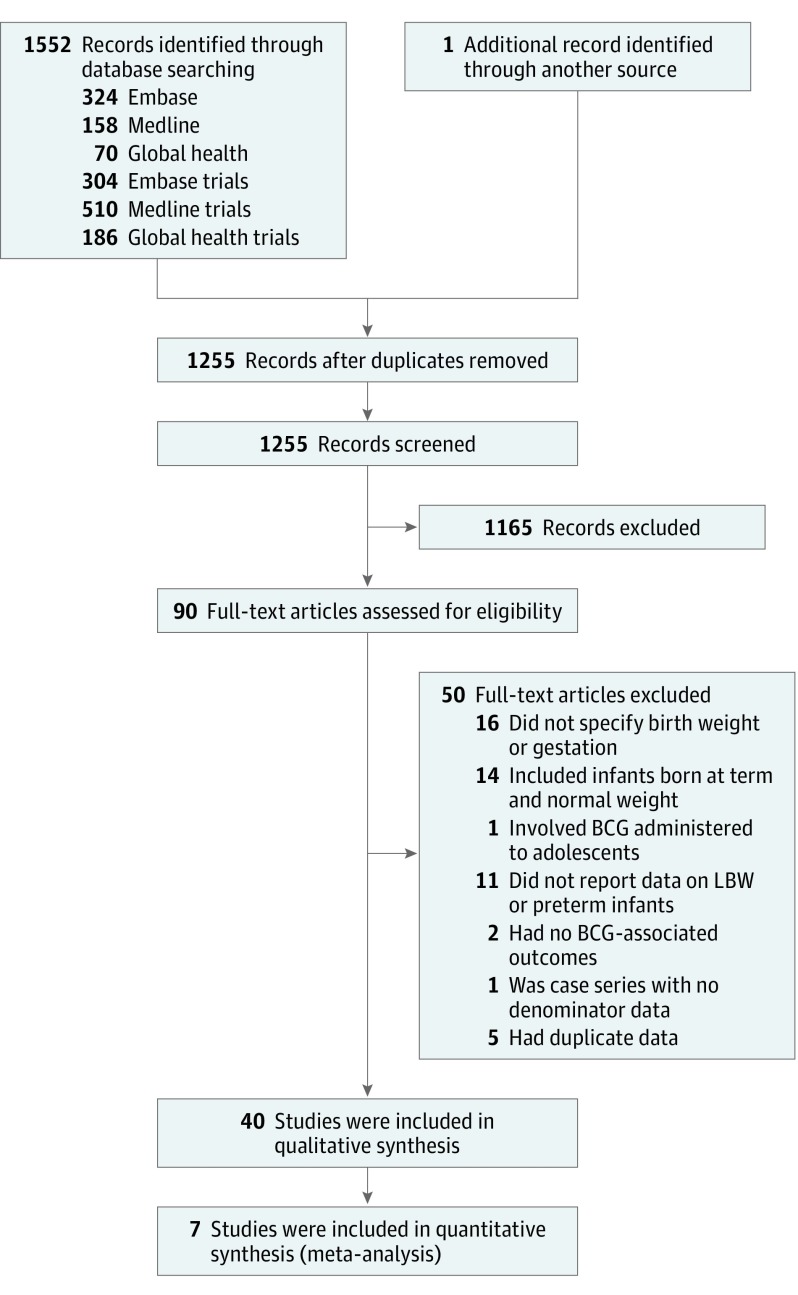
Flow Diagram of Study SelectionBCG indicates bacillus Calmette-Guérin vaccine; LBW, low birth weight.